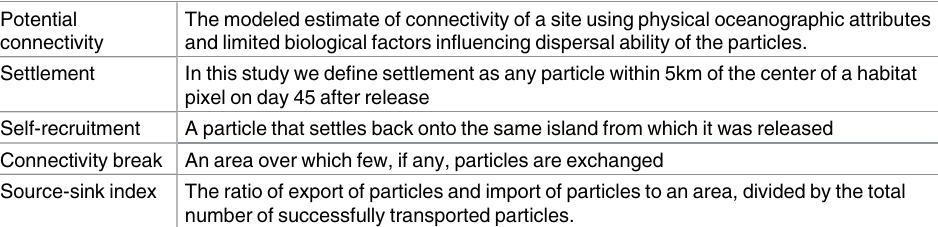
Table 1. Glossary of often used terms. Terms and definitions used throughout the HawaiianArchipelago connectivity study. Potential